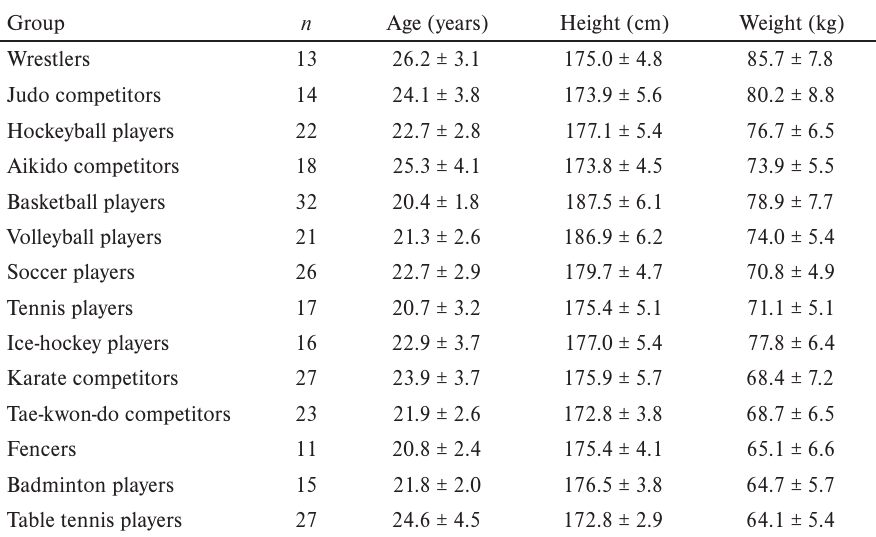
Characteristics of groups of athletes (mean ±